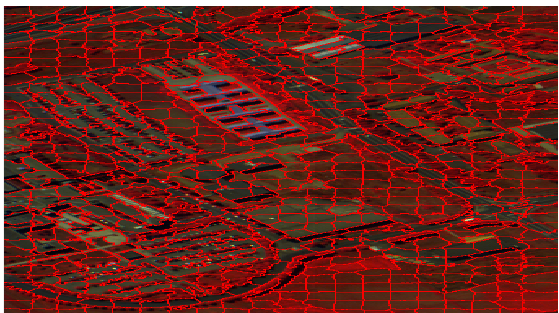
Figure 7. Results of super-pixel segmentation for Pavia